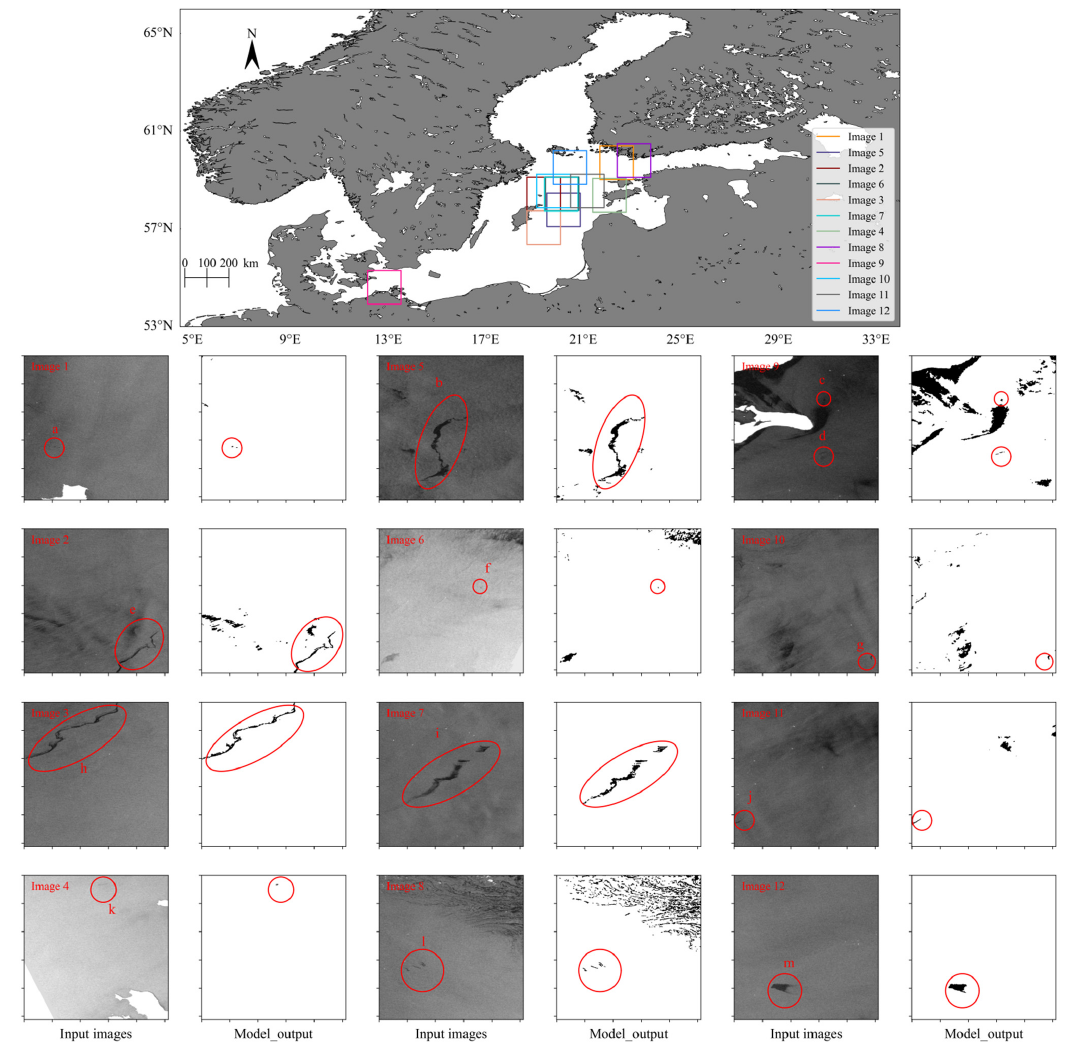
Figure 6. The successful segmentation of oil patches of various shapes and sizes in different images. The top panel shows the locations of all images. In other panels, the dark spots in the red circles are the oil patches and a~m are their numbers.